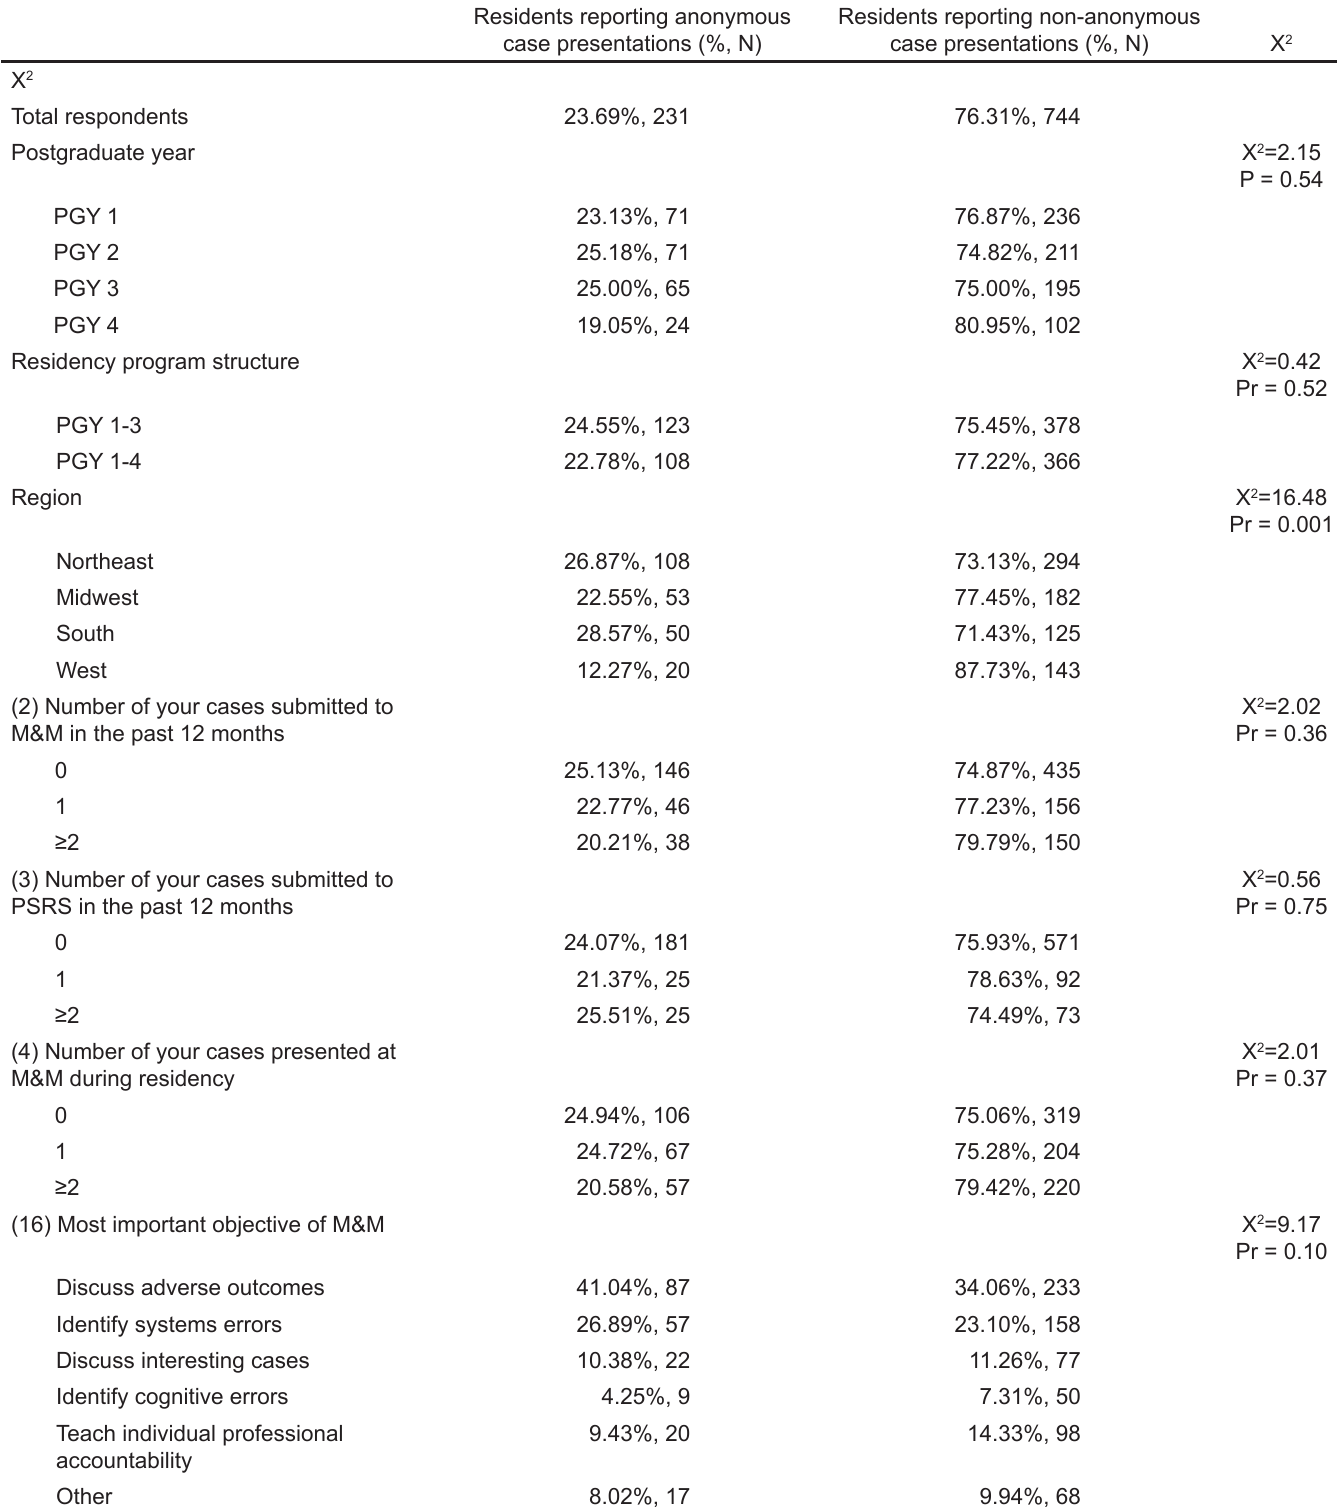
Table 1. Demographics and structure of emergency medicine morbidity and mortality